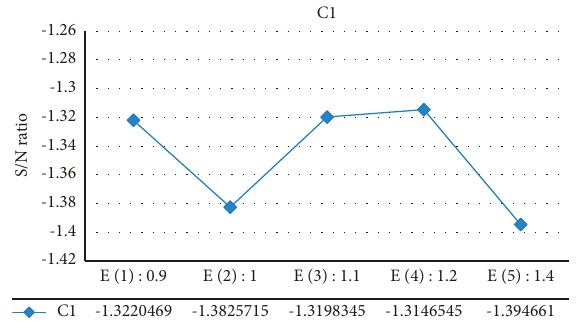
Figure 5: Graph of average S / N ratio for each level of factor C1 of PSO algorithm in model